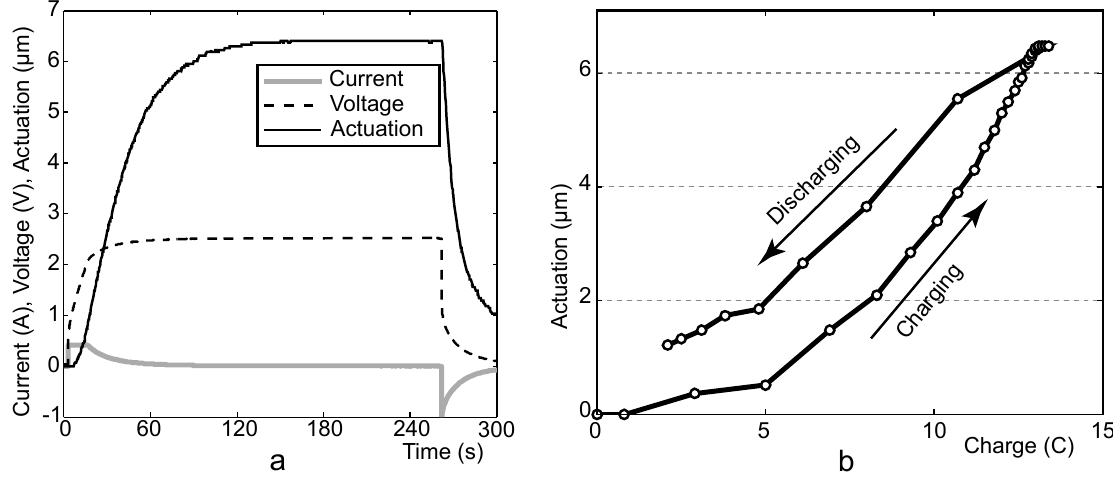
Figure 7 . CCCP measurement of EMI800 (I actuation vs . time (a) and actuation vs . charge (b).